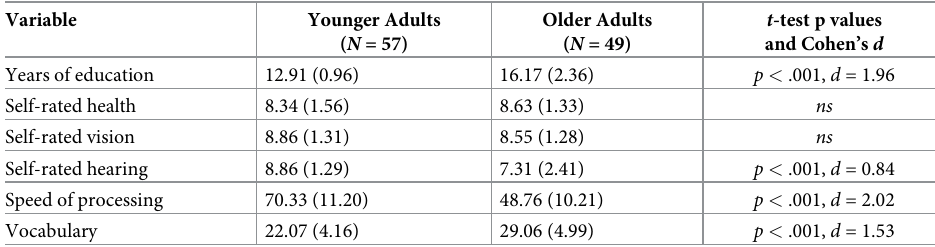
Table 1. Means and standard deviations for demographic comparisons between age groups.